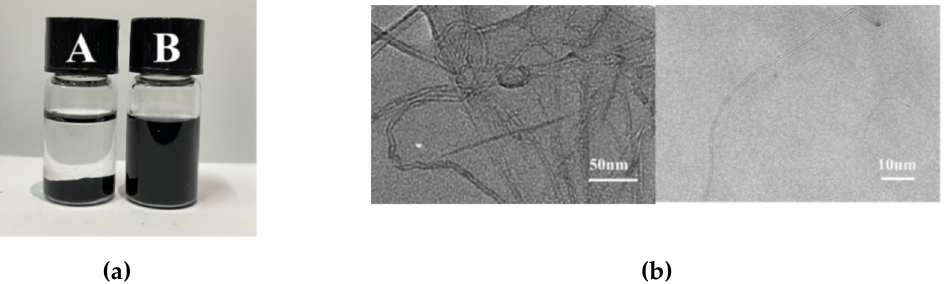
Figure 1. ( a ) Dispersion image: A is CNT-COOH and B is CNT-PDB in chlorobenzene solution; ( b ) TEM image of CNT-PDB.